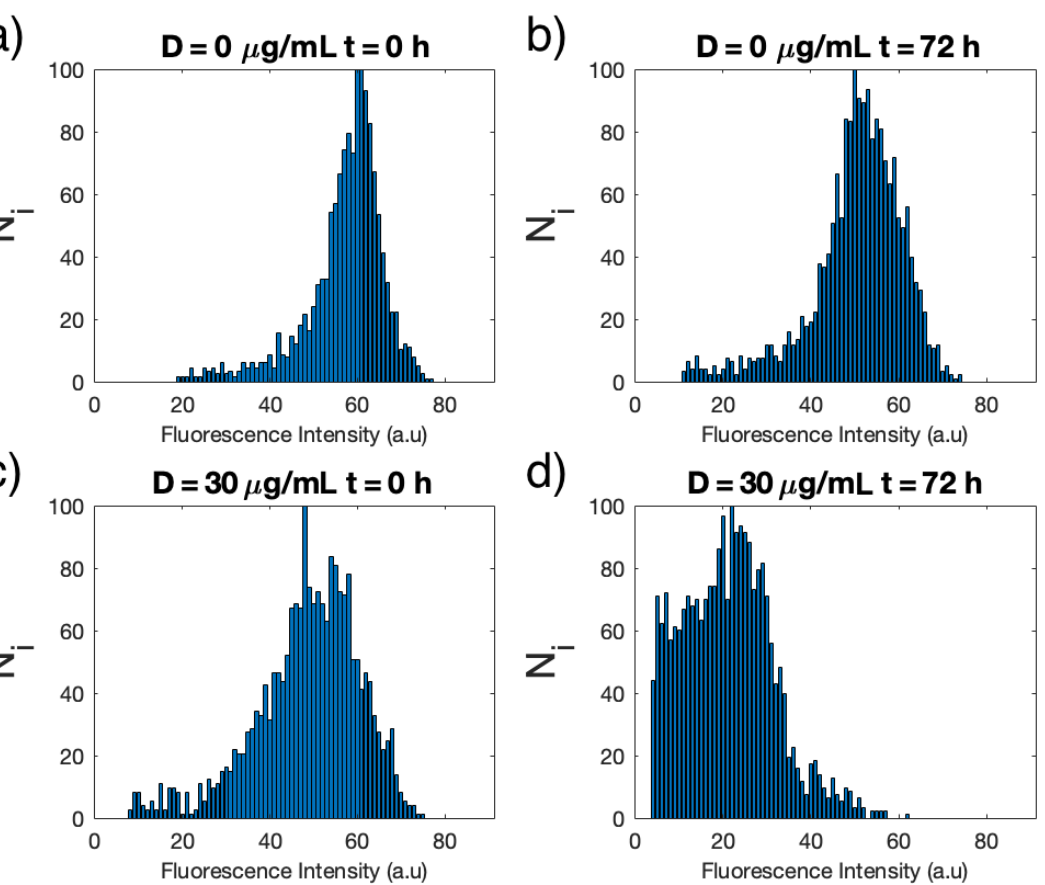
Figure 2. Histograms of the distribution of the average fluorescence intensity for each single cell of C. cimbrica of Batch 1 measured in: growth medium only (D = 0) at time t = 0 ( a ) and at t = 72 h ( b ) and with addition of 30 µ g/mL (D = 30 µ g/mL) of Cu(II) at t = 0 ( c ) and t = 72 h ( d ).